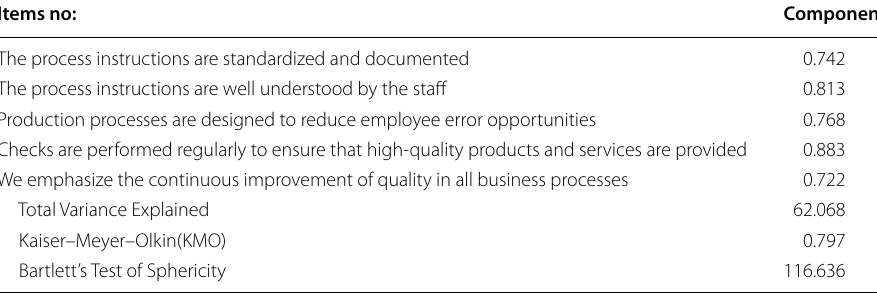
Table 3 Rotated factor for operations management